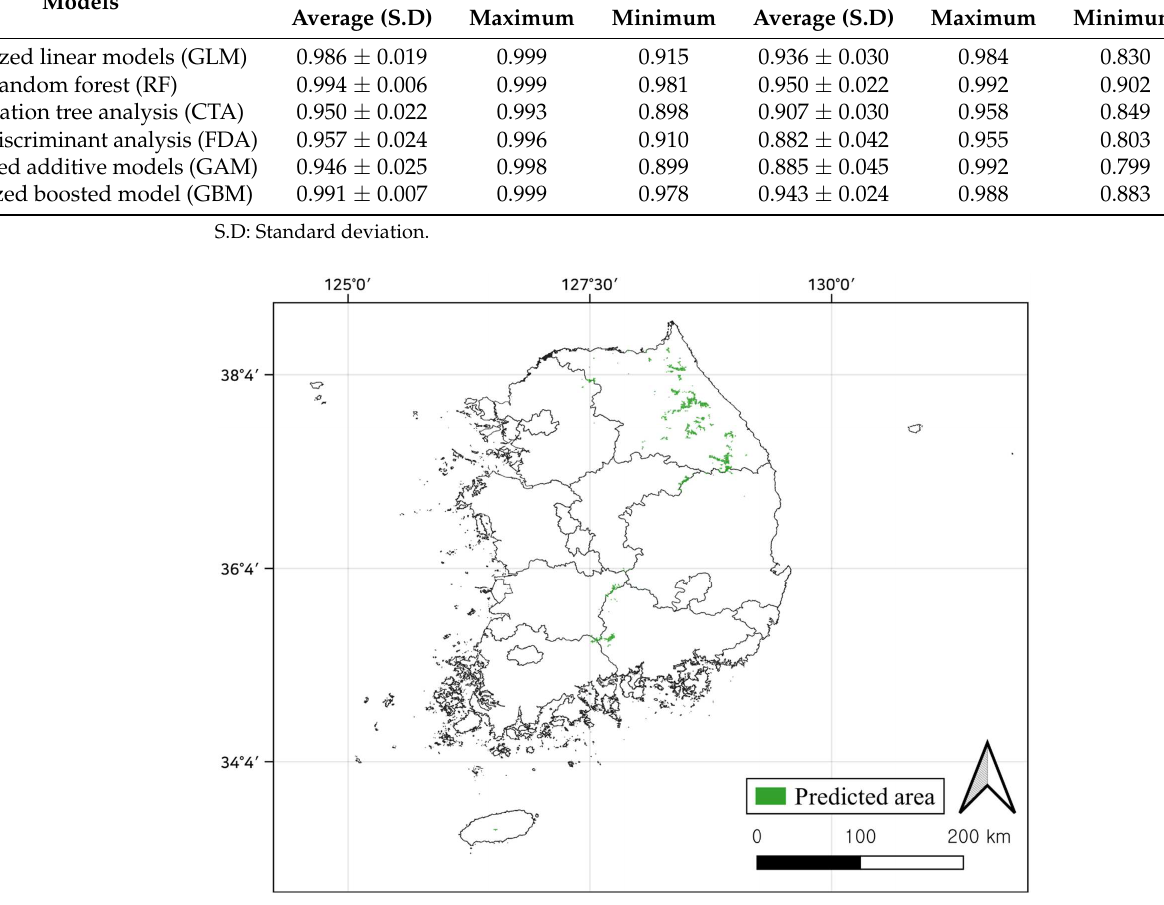
Figure 3. Predicted distribution map of Abies nephrolepis by TSS-weighted ensemble model under 1970–2000 climate conditions.